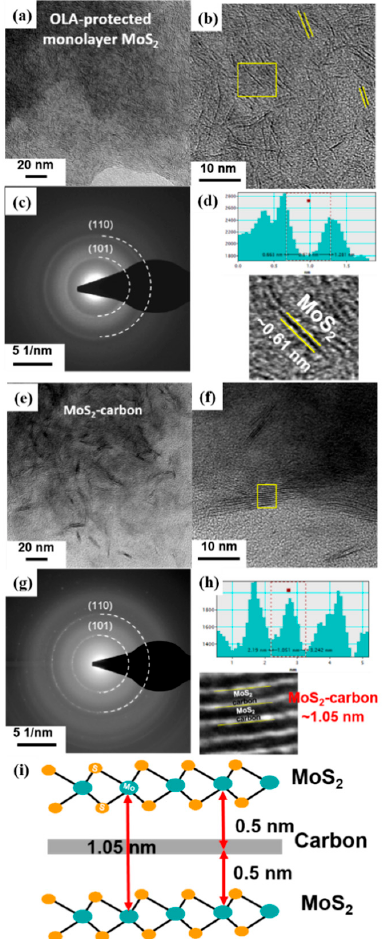
Figure 4. TEM images, HRTEM images with SADP and calibration plot for measuring the lattice spacing of ( a – d ) OLA-protected monolayer MoS 2 and ( e – h ) MoS 2 -carbon. ( i ) Schematic illustration of the MoS 2 -carbon inter-overlapped